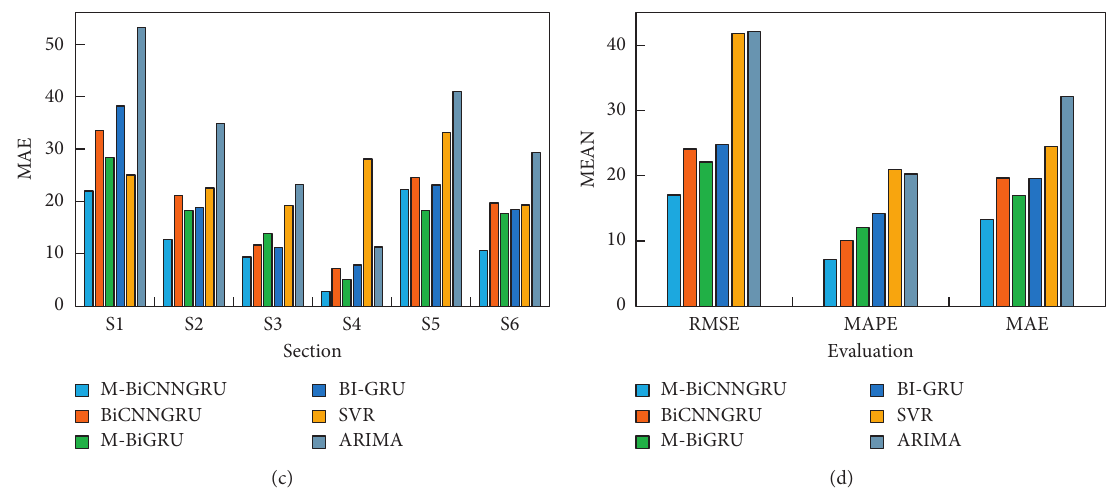
Figure 9: Comparison of prediction performance of various models.